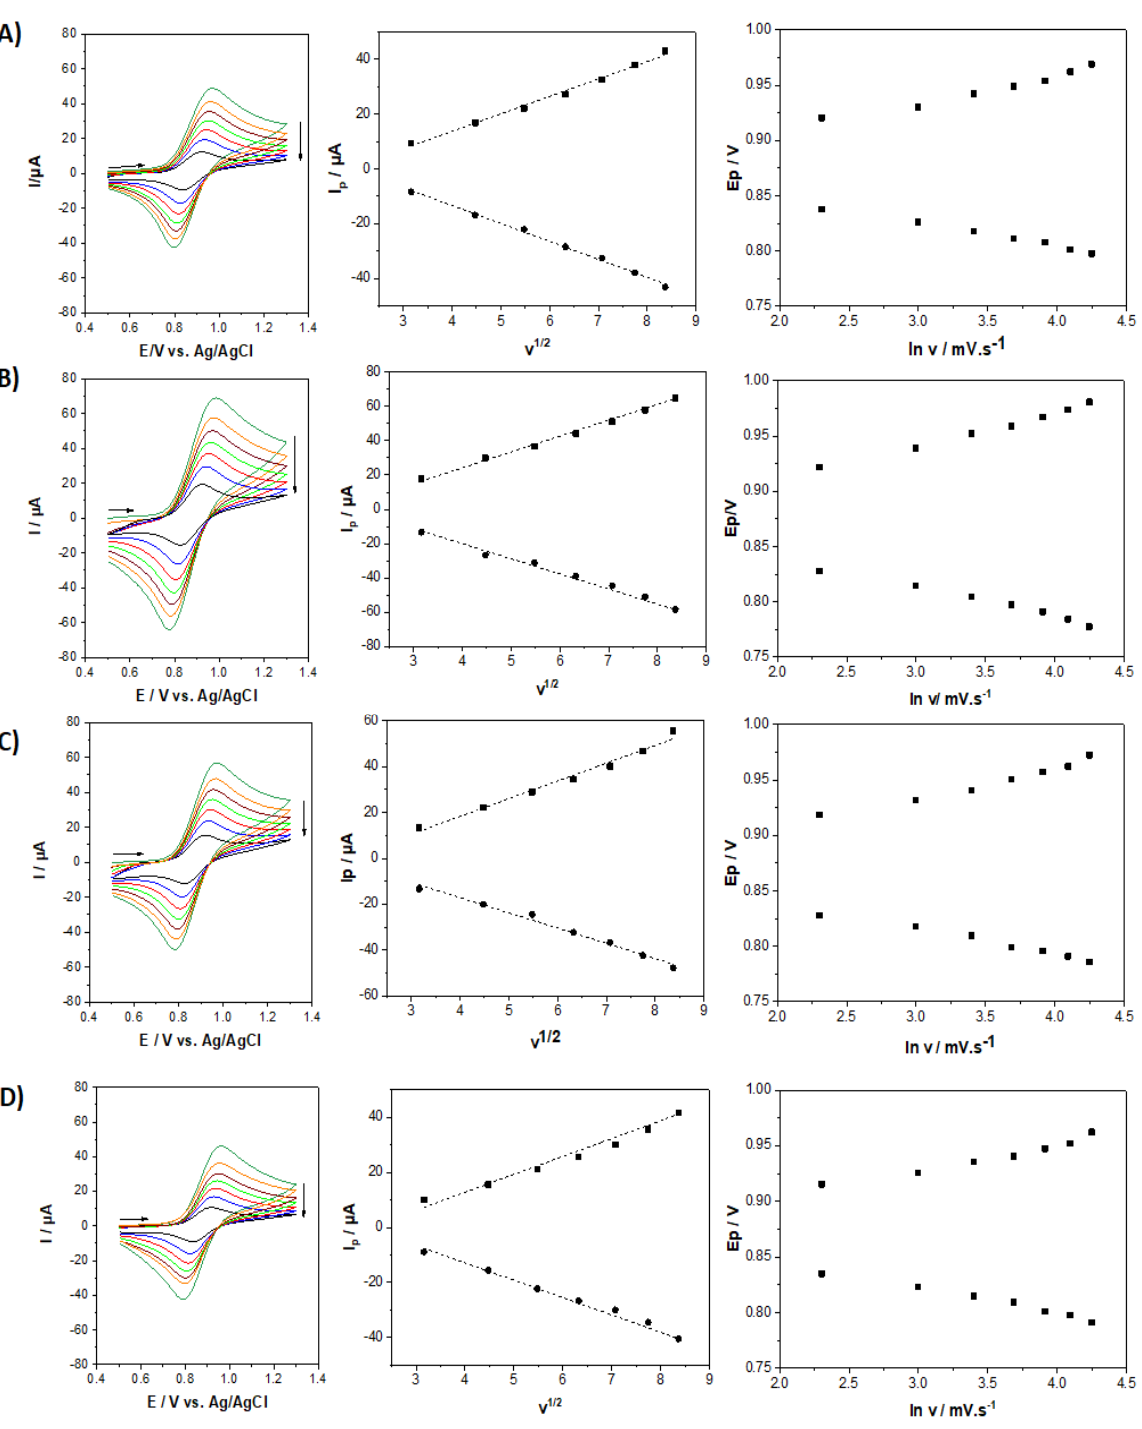
Figure 5. Cyclic voltammograms of [Fe(bpy) 3 ] 2+ SO 3 − @SiO 2 functionalized films recorded at potential scan rates of 10, 20, 30, 40, 50, 60, and 70 mV s − 1 in an aqueous electrolyte solution containing 0.1 M NaNO 3 . Left: CVs of the films prepared from various MPTMS/TEOS ratios (total concentration of silane precursors: 200 mM): 30/70 ( A ); 20/80 ( B ); 10/90 ( C ); 5/95 ( D ). Middle: Dependence of the peak current with the square root of the potential scan rate. Right: Evolution of peak potentials as a function of the logarithm of potential scan rate.